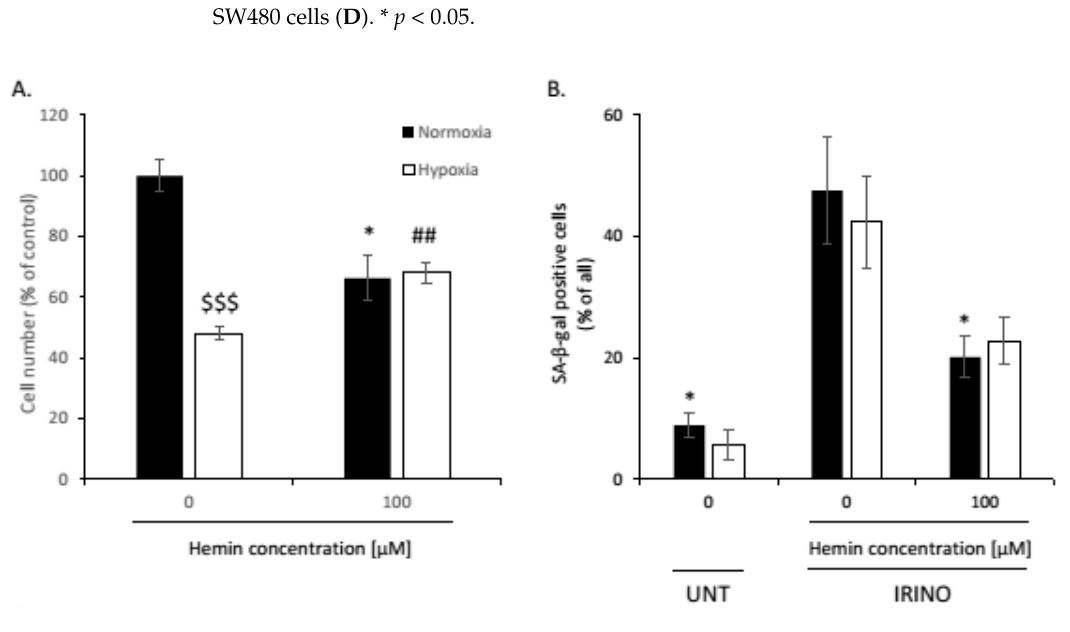
Figure A12. Cont